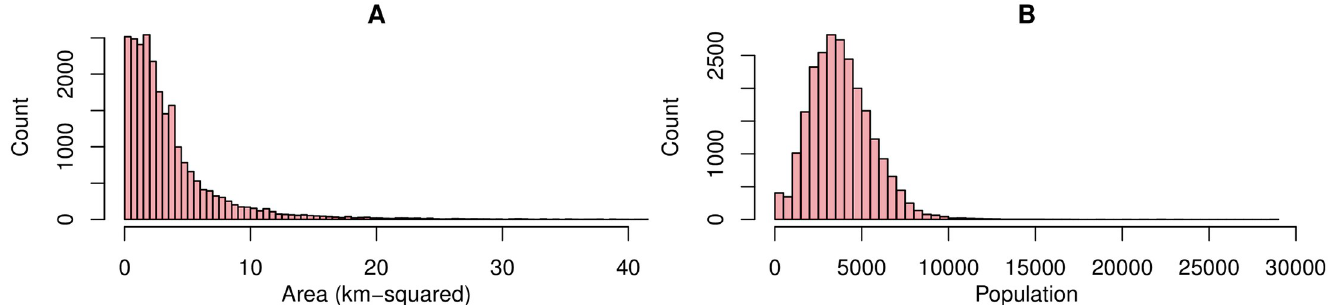
Fig 1. Distribution of area and population of census tracts. A: Frequency distribution of area in kilometer squared and B: population of census tracts included in the study.